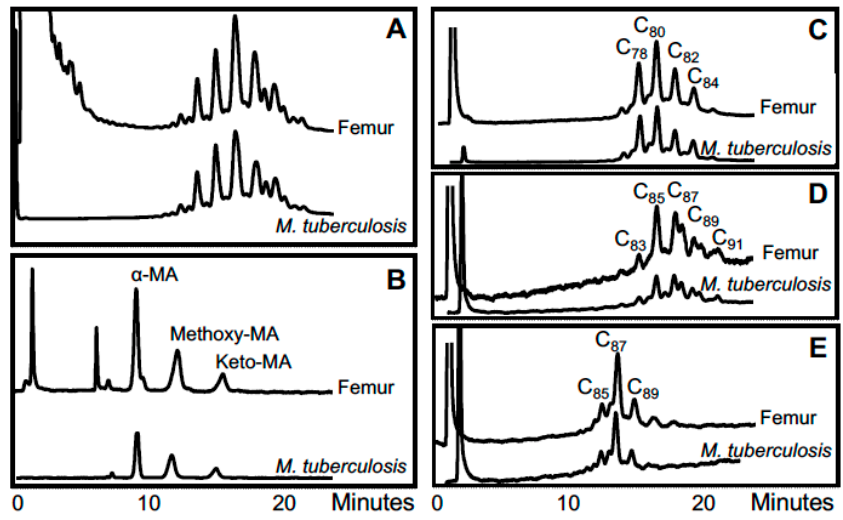
Figure 4. Lipid biomarker profiles for femur of Granville mummy [55]. A . Total mycolates, reverse phase HPLC; B . Collected total mycolates (MAs), normal phase; C . Collected α -mycolates, reverse phase; D . Collected methoxymycolates, reverse phase; E . Collected ketomycolates, reverse phase.